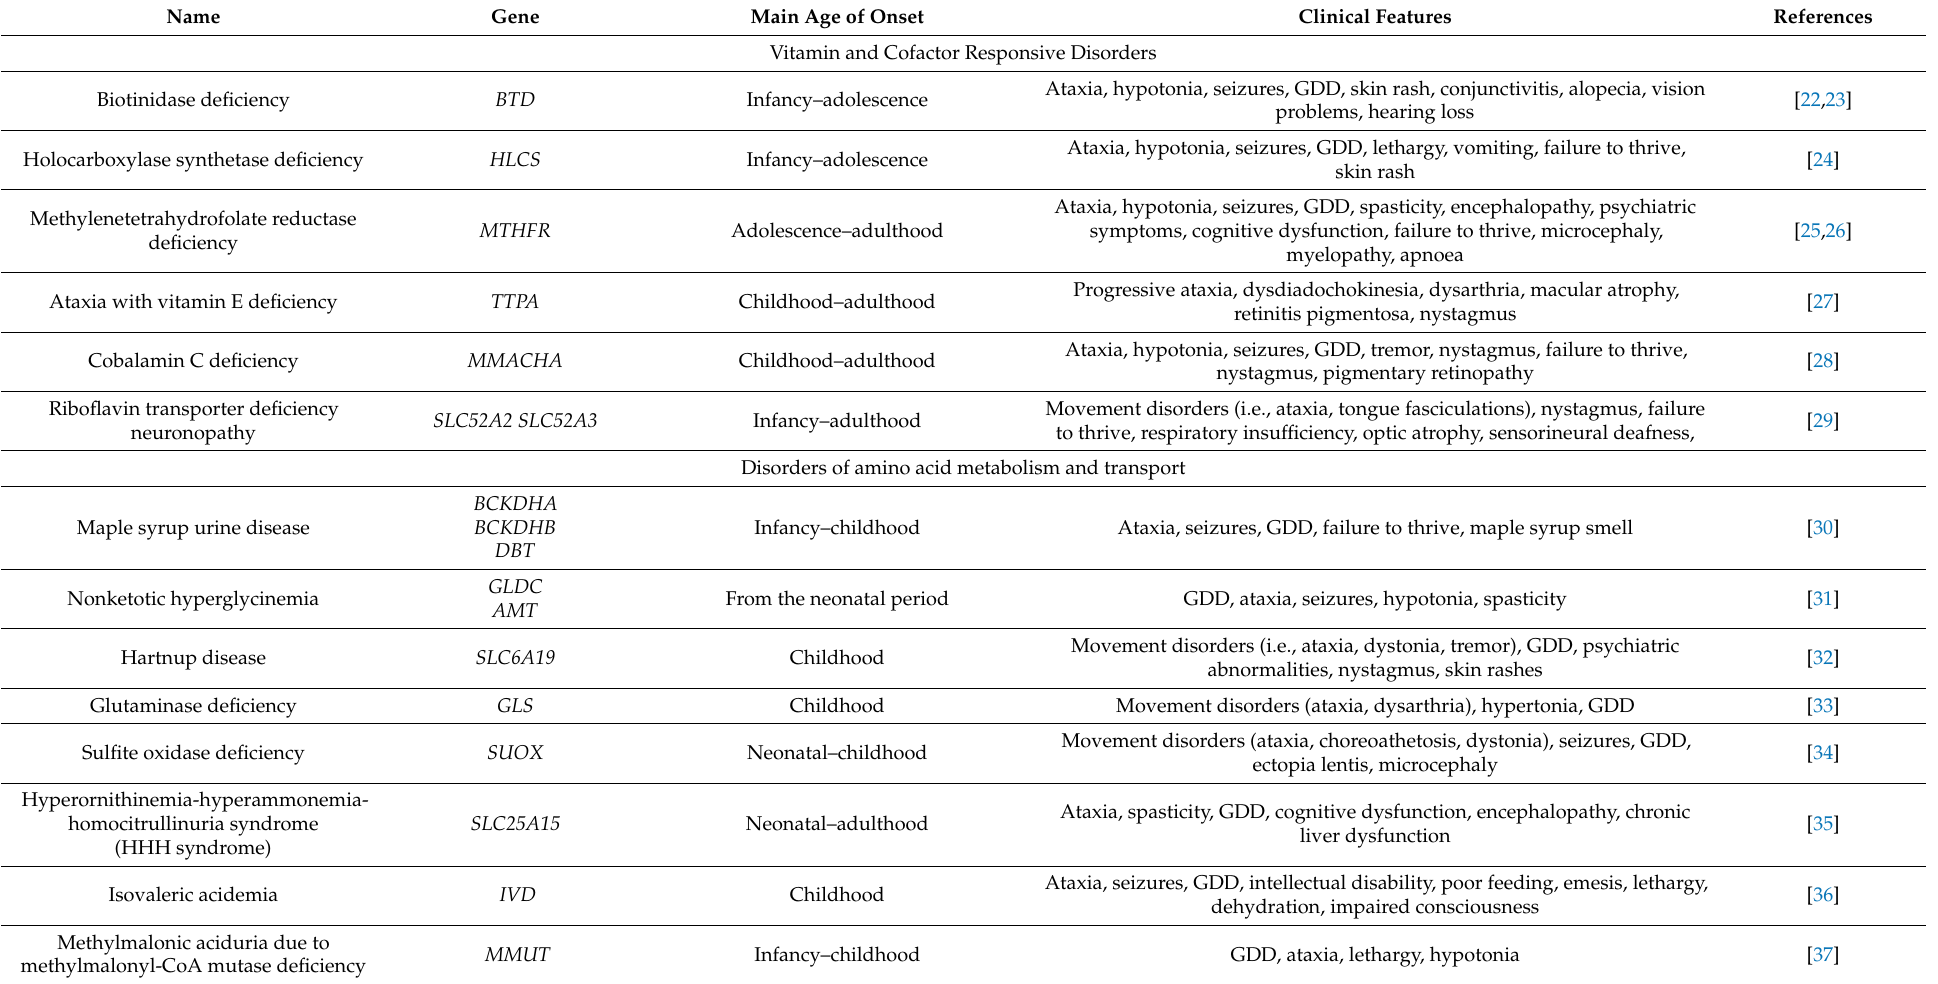
Table 1. Clinical features of neurometabolic disorders presenting with